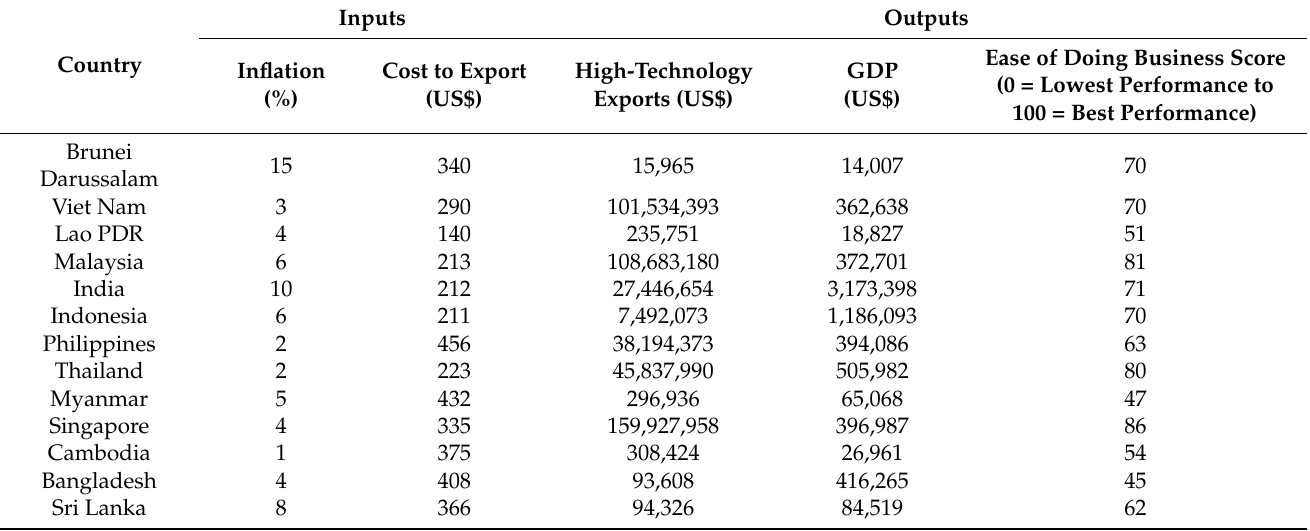
Table A1. Super-SBM Model’s Data.